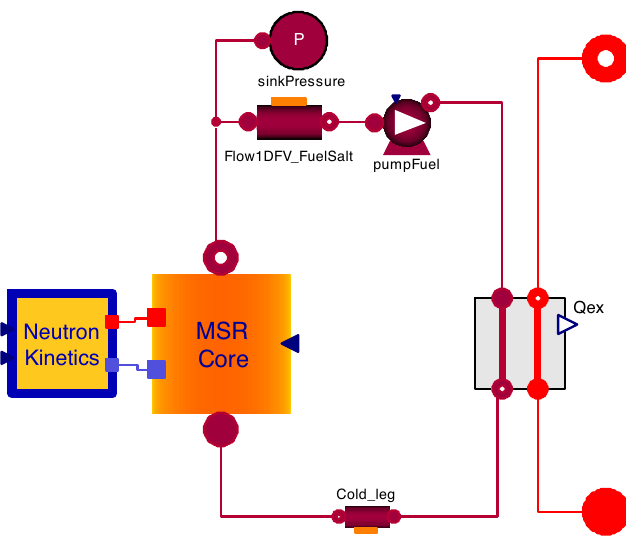
Fig. 5. Object-oriented Modelica model of the fuel